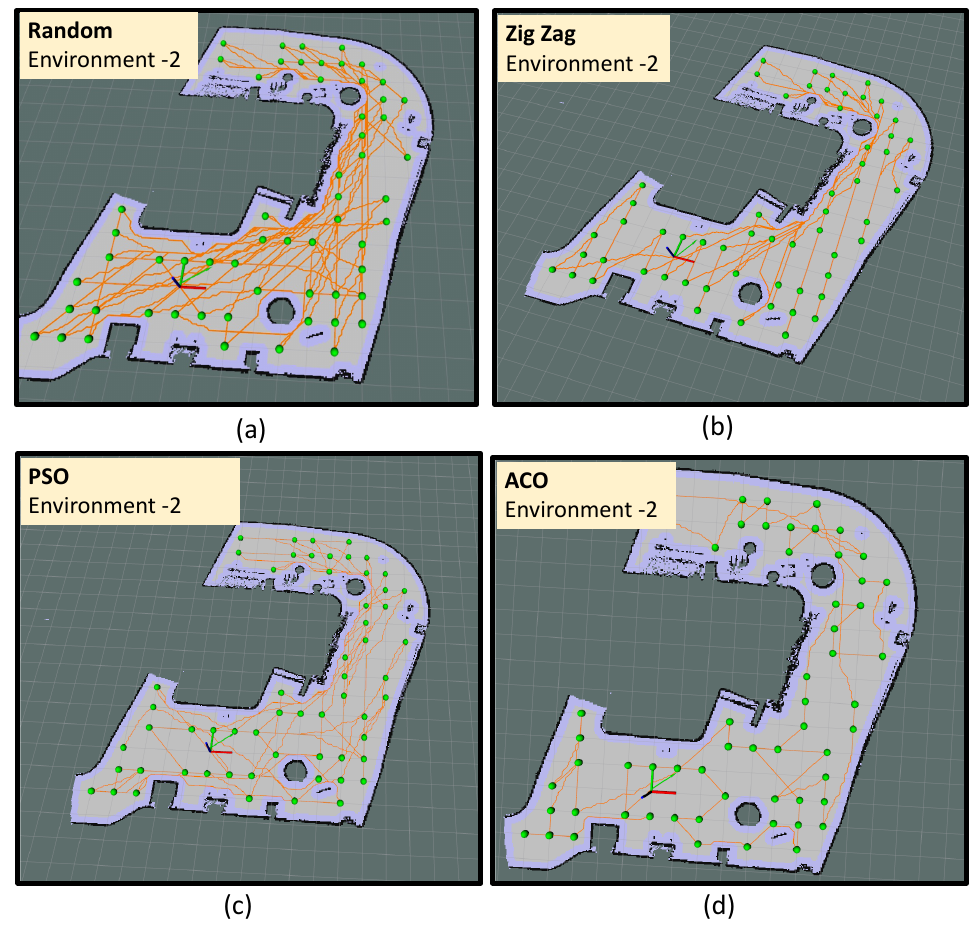
Figure 14. The path followed by the robot in environment-3 using random selection of points ( a ), using zig-zag selection of points ( b ), PSO algorithm ( c ) and ACO algorithm ( d